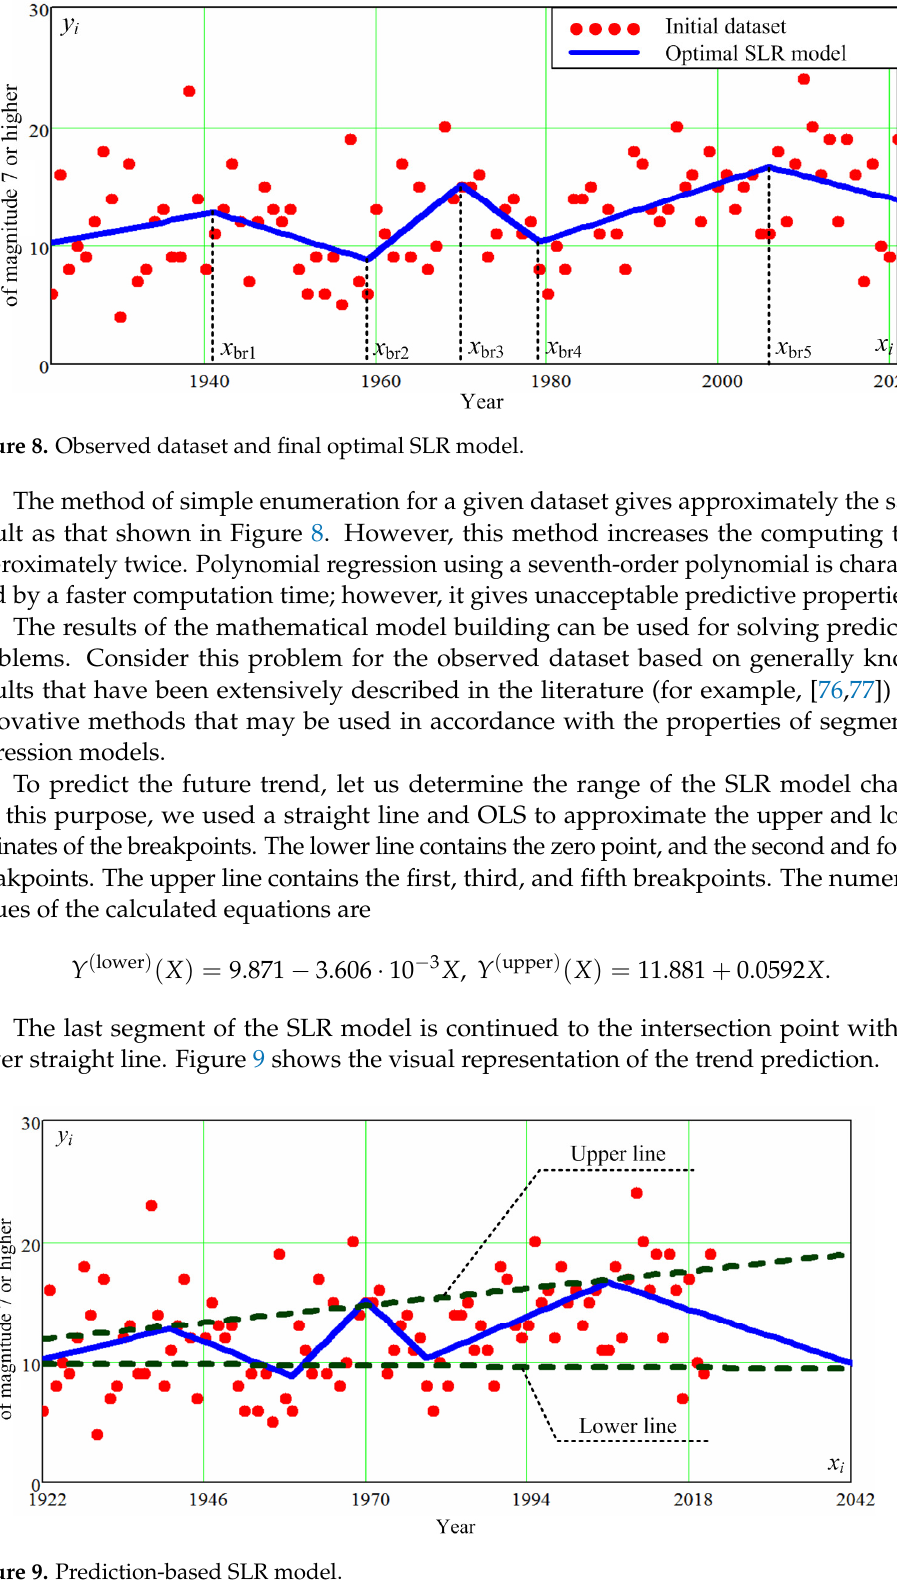
Figure 9. Prediction-based SLR